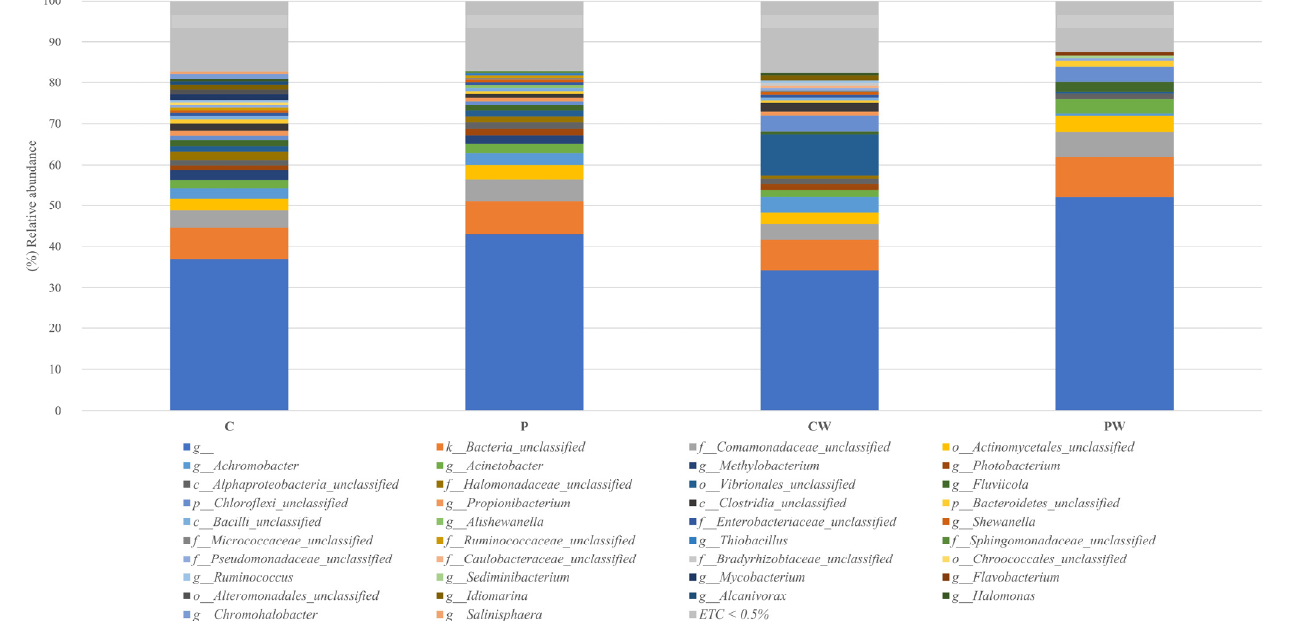
Figure 4. Relative abundance (%) of bacteria at genera level in the skin mucus microbiota of fish feed with control diet without (C) and with wound (CW); fish feed with probiotic diet without (P) and with wound (PW). ETC: relative abundance <0.5% in average; g__non taxonomy classify OTUs at this categorize.